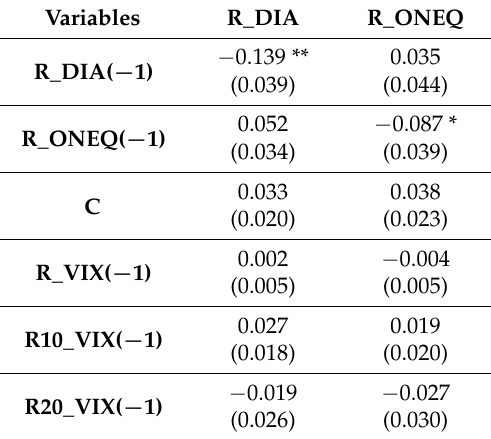
Table 6. US Market ETF and VIX VAR.